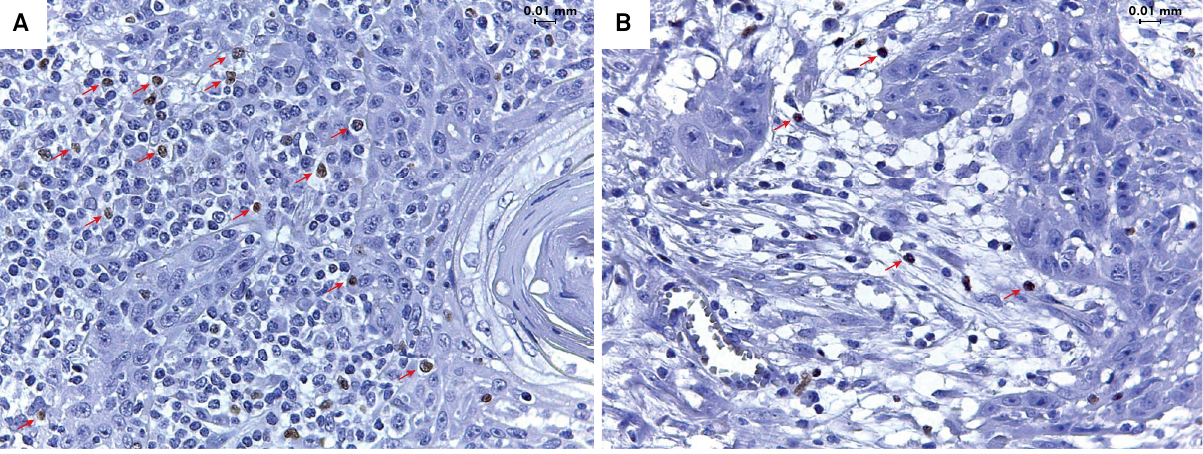
Figure 1. A) FoxP3+ lymphocytes (arrows) at the invasive front of low-grade LLSCC exhibiting marked inflammatory infiltrate (Advance, original magnification 400X). B) FoxP3+ lymphocytes (arrows) at the invasive front of high-grade LLSCC exhibiting slight inflammatory infiltrate (Advance, original magnification 400X).